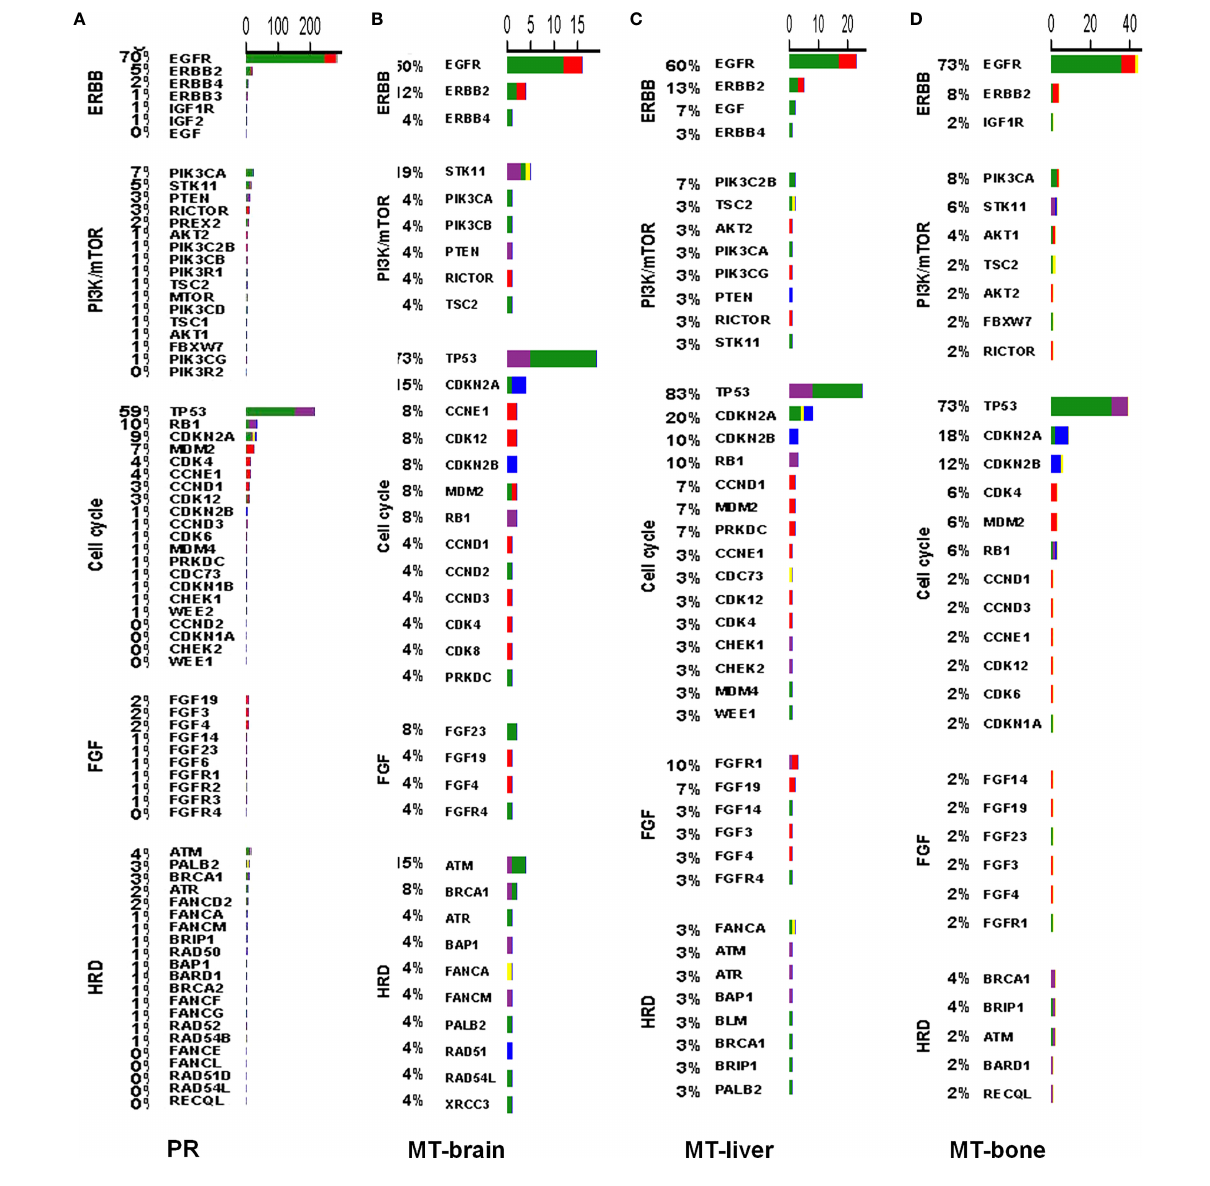
FIGURE 4 | The mutation pro fi les according to signaling pathways in PR and metastases. The mutation pro fi les of the top fi ve affected signaling pathways in (A) PR, (B) MT-brain, (C) MT-liver, and (D)